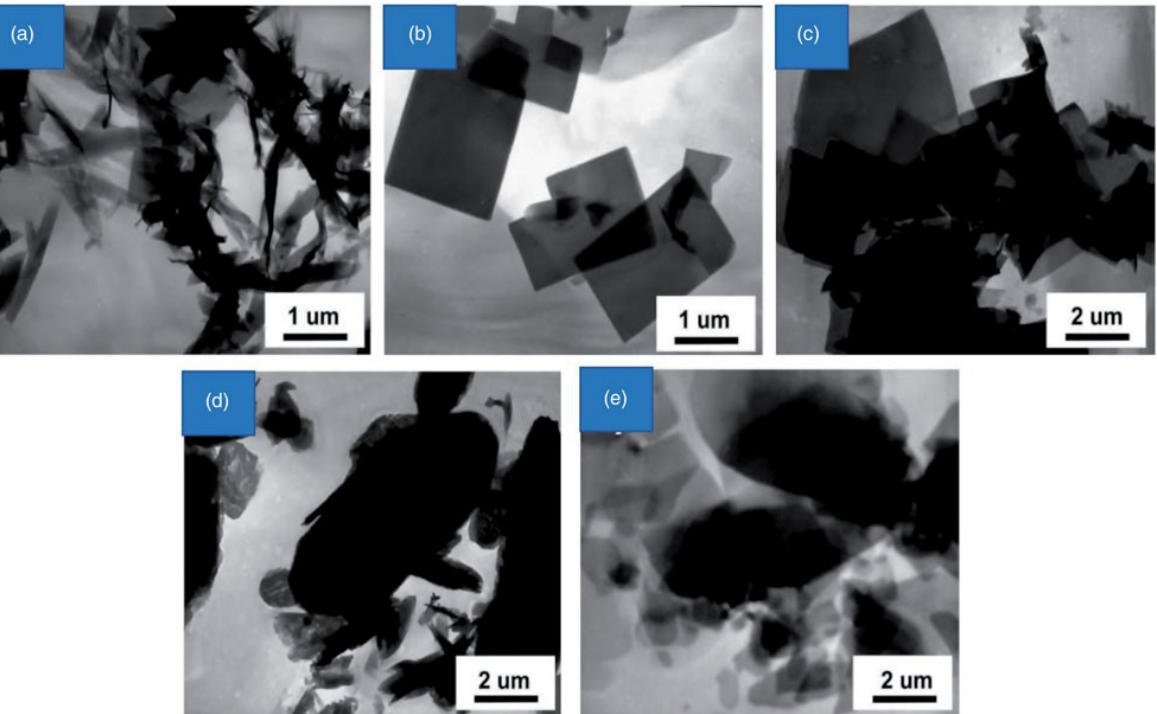
Figure 2. The transmission electron microscopic (TEM) result of [Zn(BDC) (H 2 O)]n following ( a ) 10, ( b ) 20, ( c ) 30, ( d ) 60, and ( e ) 90 min sonication [61]. Reprinted with permission from Ref. [61]. Cop- yright 2008 Elsevier.